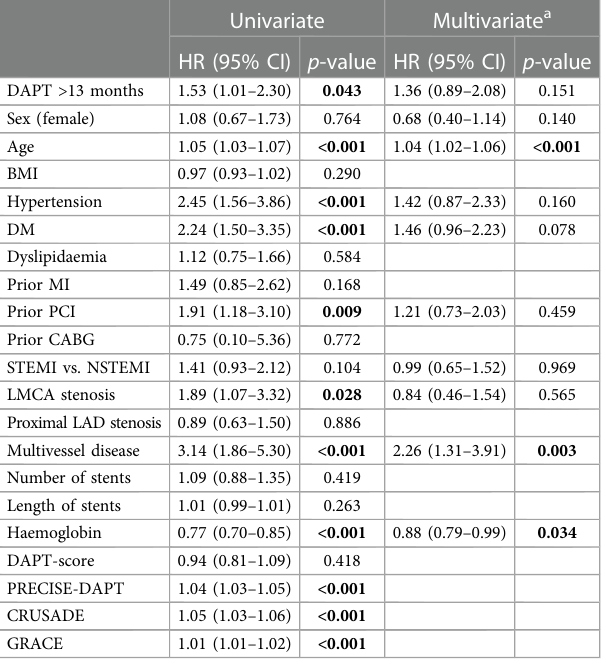
TABLE 4 Cox regression analysis for